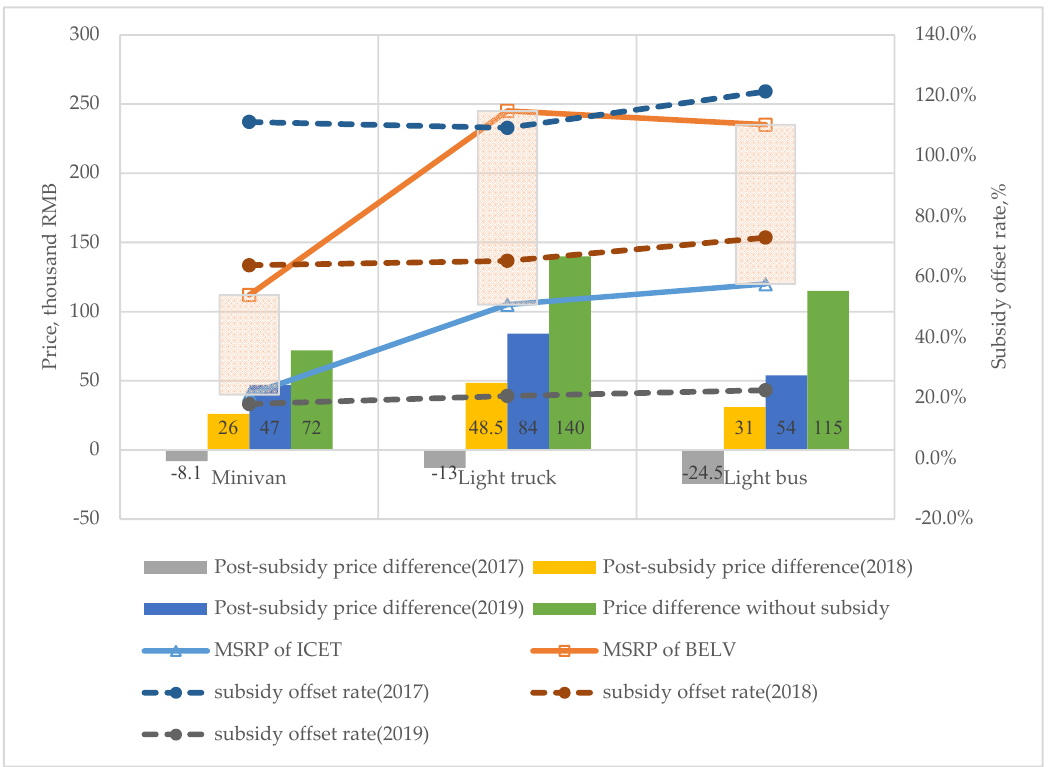
Figure 14. The price difference for the various BELVs.